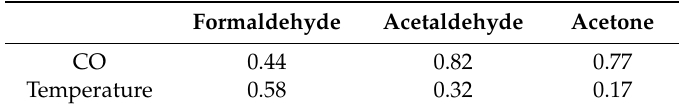
Table 3. Correlation coe ffi cients (r) among the mass concentrations of formaldehyde, acetaldehyde, acetone, and CO, temperature at MC from 16 to 25 January